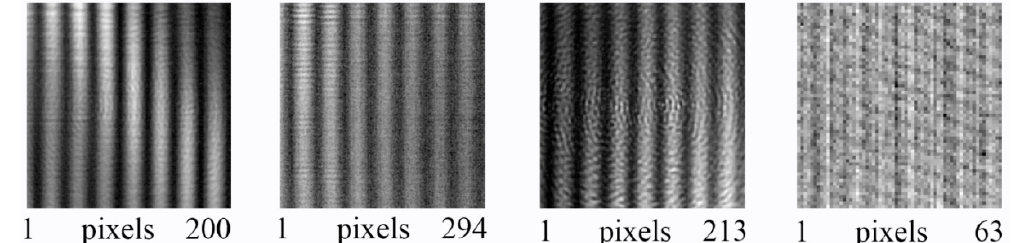
Figure 6. Central part (5 × 5 mm 2 ) of the interference pattern recorded on Cam1 to Cam4 ( Left to Right ) at λ = 118.8 μ m.